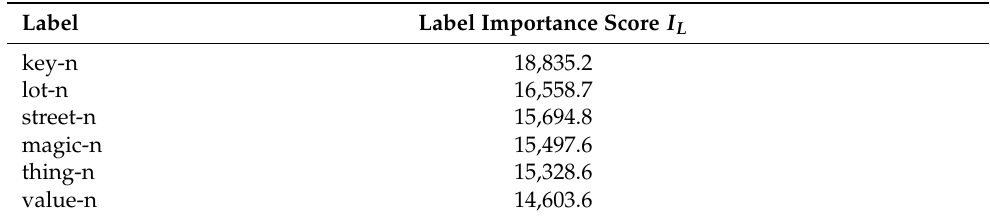
( respect-n , affection-n , friendship-n , 1